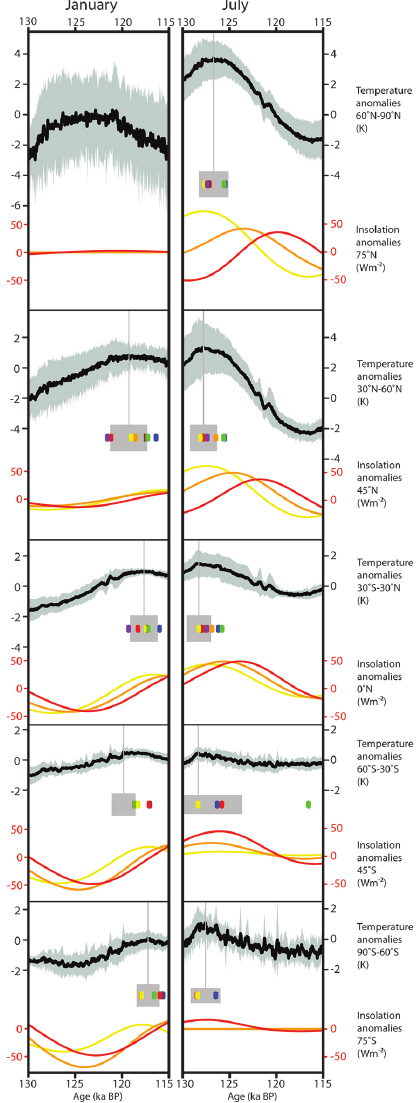
Fig. 3. Simulated 130–115 ka BP January and July MMM surface air temperature anomalies ( K ; black) and STDEV (1 σ ; grey) for five different latitude bands. The MMMs and STDEVs are calculated using the temperature time series shown in Fig. 2. Note that the number of models used in calculating the MMM and STDEV differs per latitude band and per time interval, because Bern3D has latitudinal grid limits at 76 ◦ N and 76 ◦ S and the MPI-UW and KCM simulations run only from respectively 128–115 ka BP and 126–115 ka BP. Furthermore, the applied orbital acceleration in the CCSM3 and KCM and the applied periodically synchronous integration in MPI-UW impact the size of the STDEV (see also Sect. 2.3). The vertical grey lines give the MMM mid-points of the period of maximum warmth. The width of the corresponding grey box gives the spread in the periods of maximum warmth of the individual simula- tions (1 σ ) while its height gives an indication of the number of simulations used in the calculation (see Fig. 2). This model spread is further illustrated by the depicted mid- points of the individual periods of maximum warmth (see Fig. 2 for the corresponding colour coding). The period of maximum warmth is only shown if for at least four in- dividual simulations we find a maximum temperature along the polynomial which is outside the 1 σ range of the model individual LIG mean. Also shown in this figure are the corresponding 130–115 ka BP insolation anomalies for the mid-latitude of the chosen latitude bands ( W m − 2 ). The left-hand column gives the December (yellow), January (orange) and February (red) insolation anomalies, while in the right-hand col- umn insolation anomalies for June (yellow), July (orange) and August (red) are given. All values are anomalies relative to pre-industrial values.